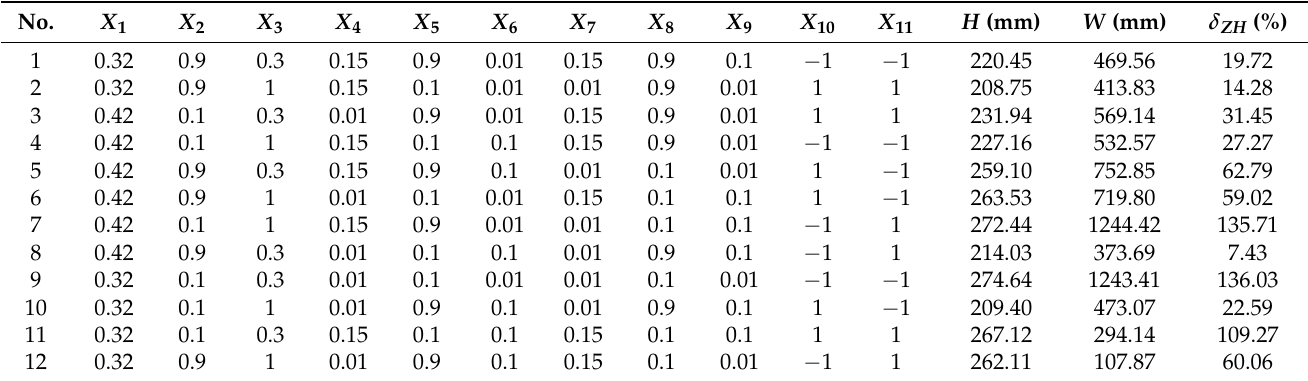
Table 3. Plackett–Burman test scheme and results.